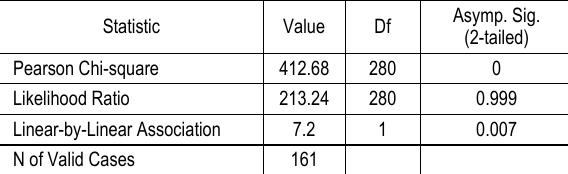
Table. Likelihood to take risk versus economic